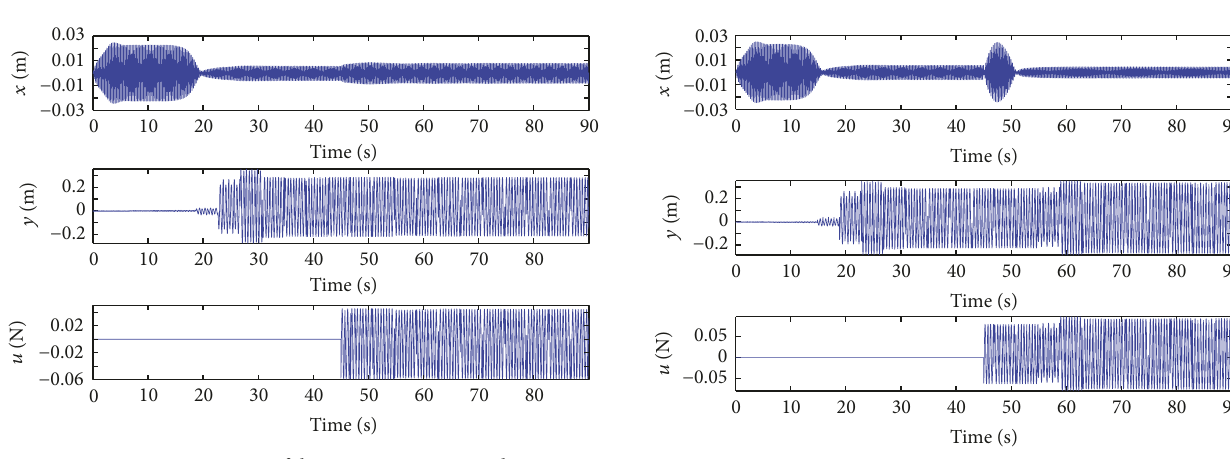
Figure 12: Details of the experimental platform under active control scheme: accelerometer, strain gage, and PZT patch.